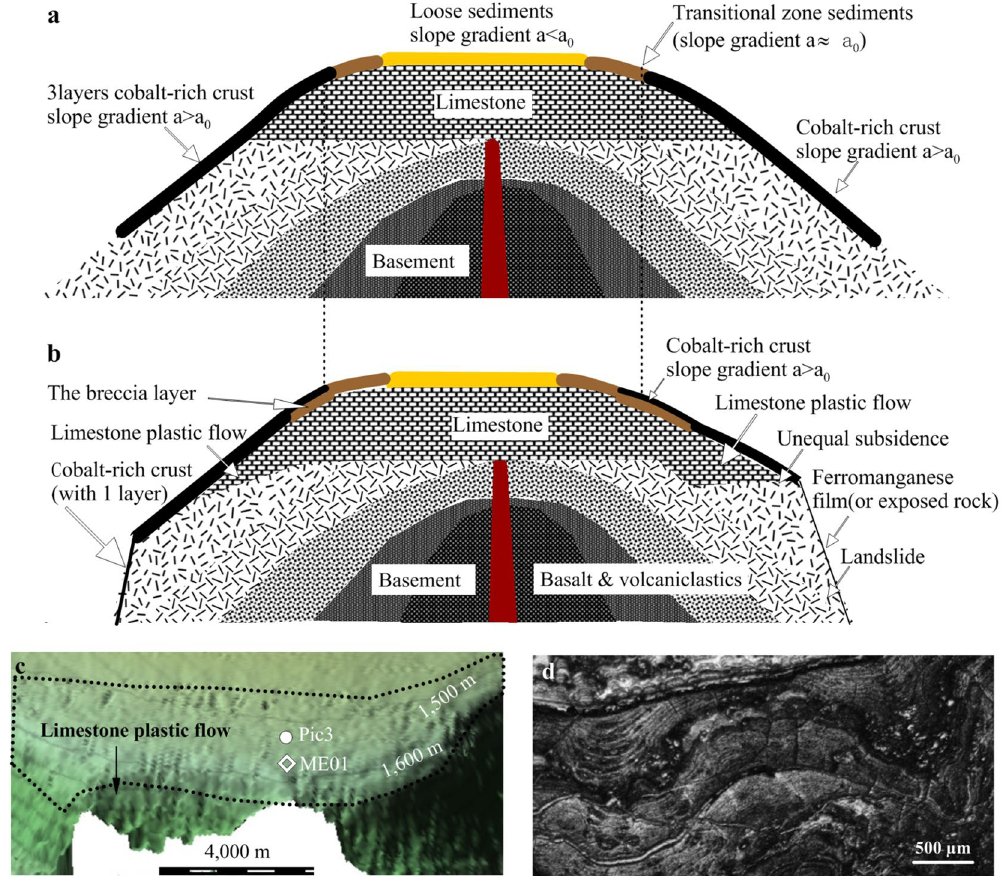
Figure 5. Extinct seamount evolution. ( a ) Seamount structure and depositions on its slopes. ( b ) Slope topography changed, and the depositional patterns adjusted accordingly. Gentle slope topography changes could be caused by unequal subsidence and plastic flow of rocks overlying the basement moving down slope. ( c ) Plastic flow of limestone on the slope shown in Fig. 2a. ( d ) Micro-deformation structures in the section of cobalt-rich crust overlying limestone that could be caused by plastic